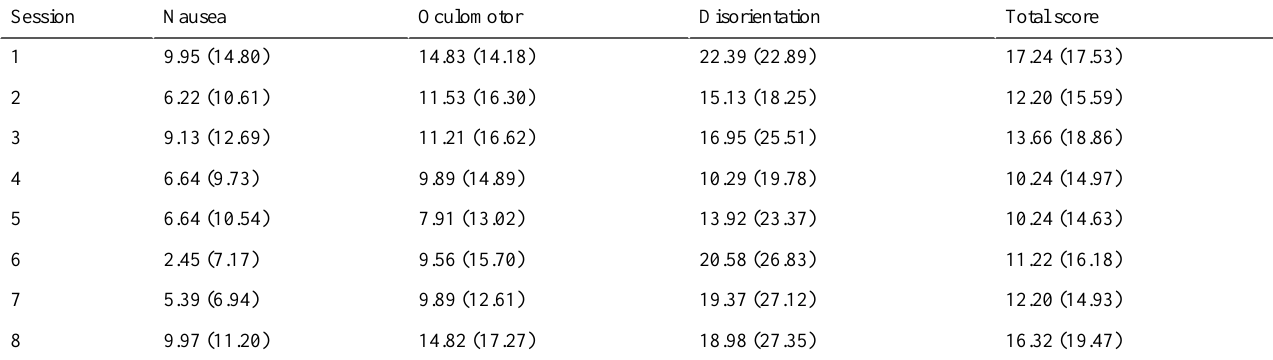
Table 5. Mean (SD) simulator sickness questionnaire scores associated with the virtual reality cognitive training